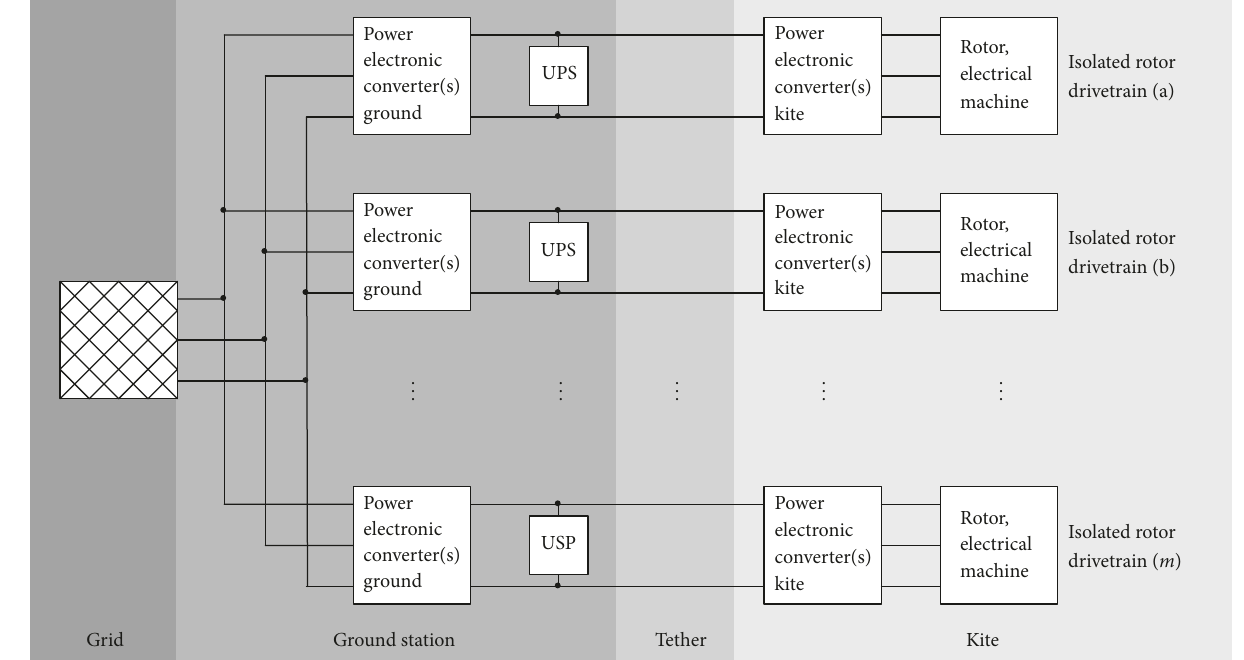
Figure 9: Block diagram of the proposed solution “isolated drivetrains.”